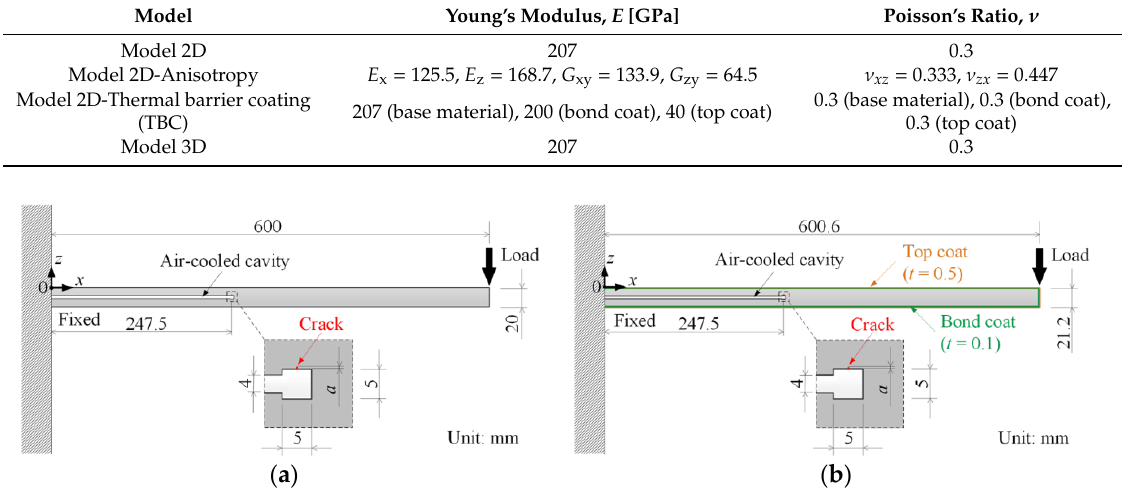
Figure 1. Shape and dimensions of the two-dimensional models: ( a ) Model 2D and Model 2D-Anisotropy; ( b ) Model 2D-Thermal barrier coating (TBC).